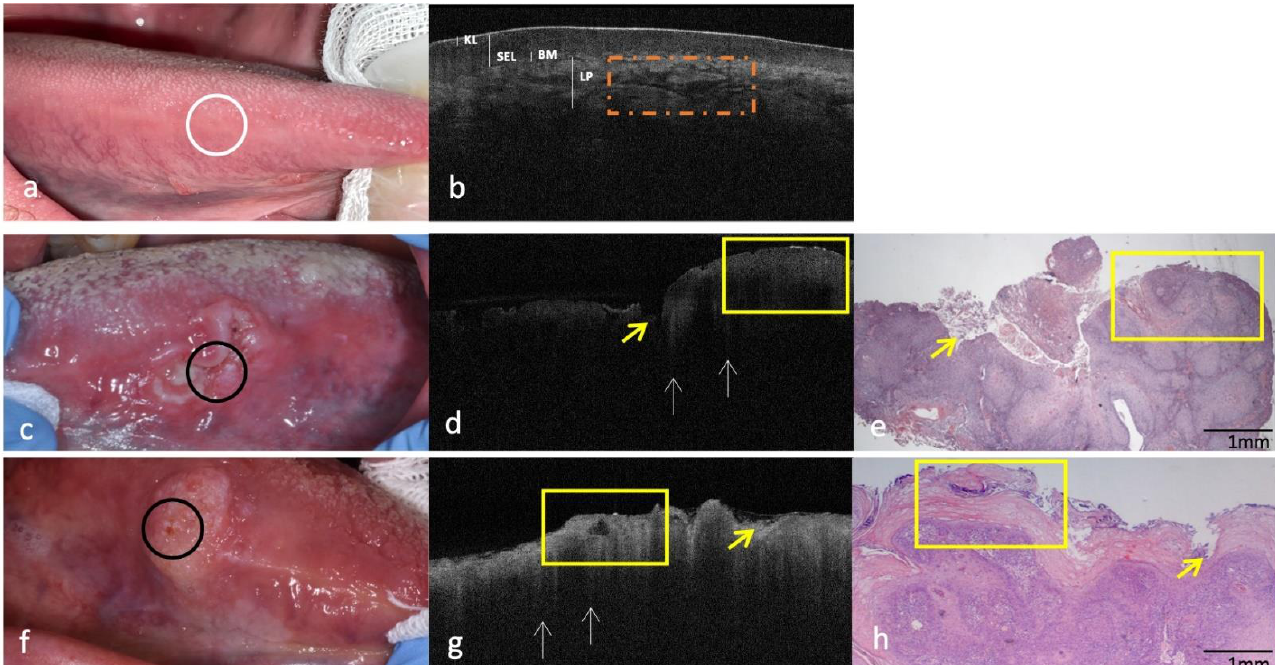
Figure 2. Clinical, OCT and histopathology images of two cases of OSCC on the lateral borders of the tongue compared with the same healthy site (code C02.1). ( a , b ): Clinical and OCT images of healthy mucosa of the border of tongue; the site of in vivo OCT evaluation is indicated with a white circle. ( c – h ): Clinical, OCT and histopathological images (H-E stain; original magnification ×25) of two OSCCs on the border of tongue; the site of in vivo OCT evaluation is indicated with a black circle; “ icicle-like ” structures are indicated with white arrows; superficial ulcerations and exophytic morphology are indicated by yellow arrows and yellow box, respectively; streaking pattern of LP is indicated by a dotted orange box. KL – Keratinized layer; SEL — Stratified Epithelial Layer; BM — Basement Membrane; LP — Lamina Propria.